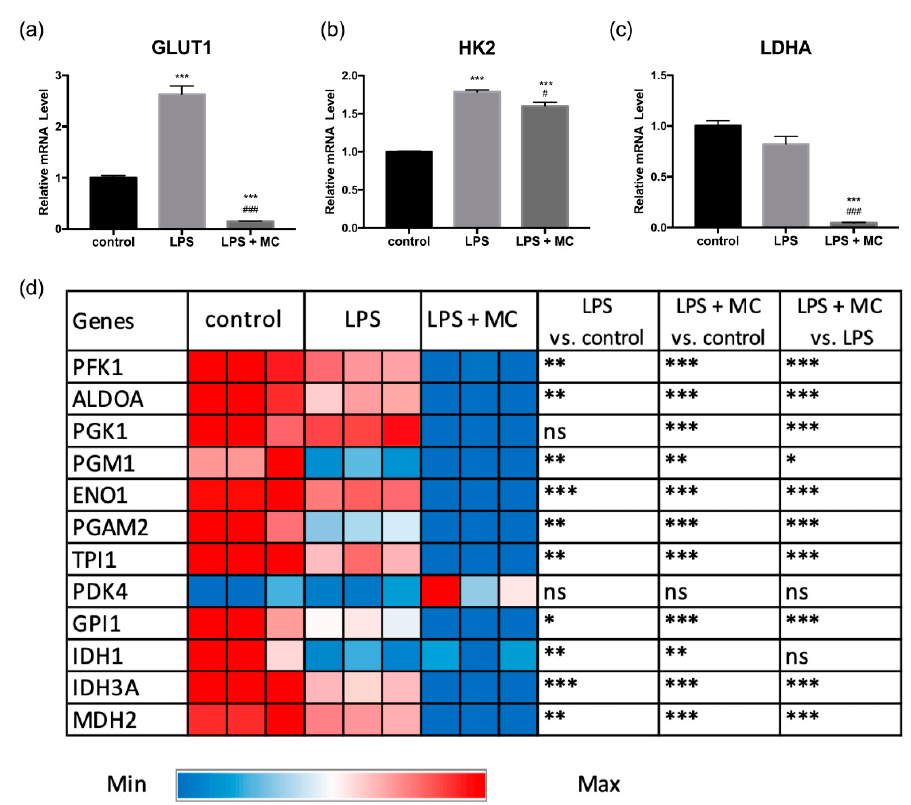
Figure 3. E ff ect of LPS and MC treatment on the expression of genes in glucose metabolism: ( a ) GLUT1 , ( b ) HK2 , and ( c ) LDHA. ( d ) Heatmap showing the expression of 12 selected genes including PFK1 , ALDOA , PGK1 , PGM1 , ENO1 , PGAM2 , TPI1 , PDK4 , GPI1 , IDH1 , IDH3A , and MDH2 . RAW264.7 macrophages were pre-treated with MC water extract for four hours, followed by incubation with